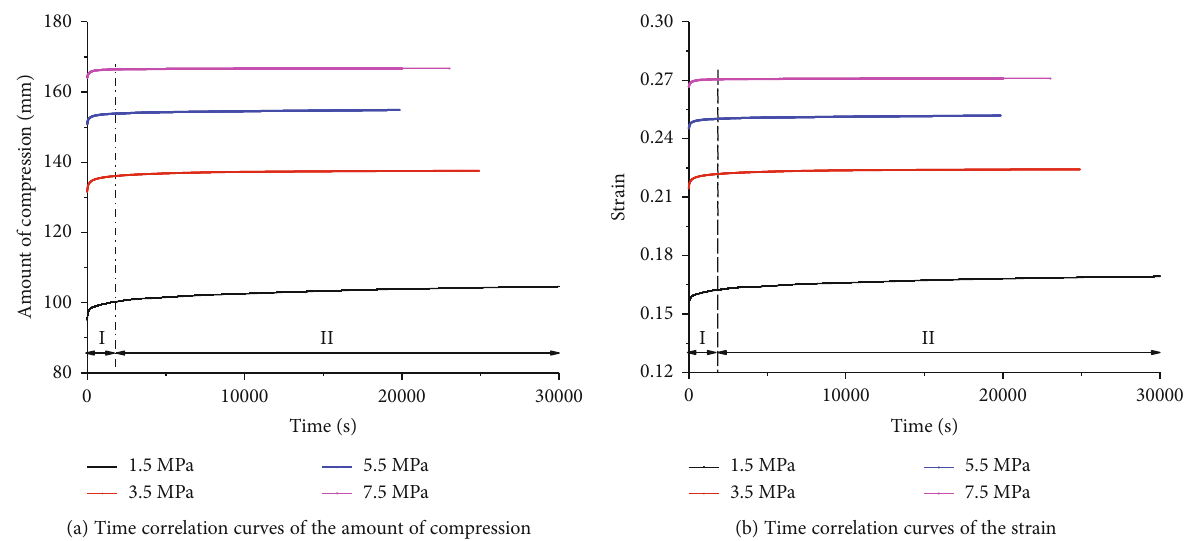
Figure 6: Time correlation curves of the amount of compression and strain for caving crushed rock samples of di ff erent axial stresses.